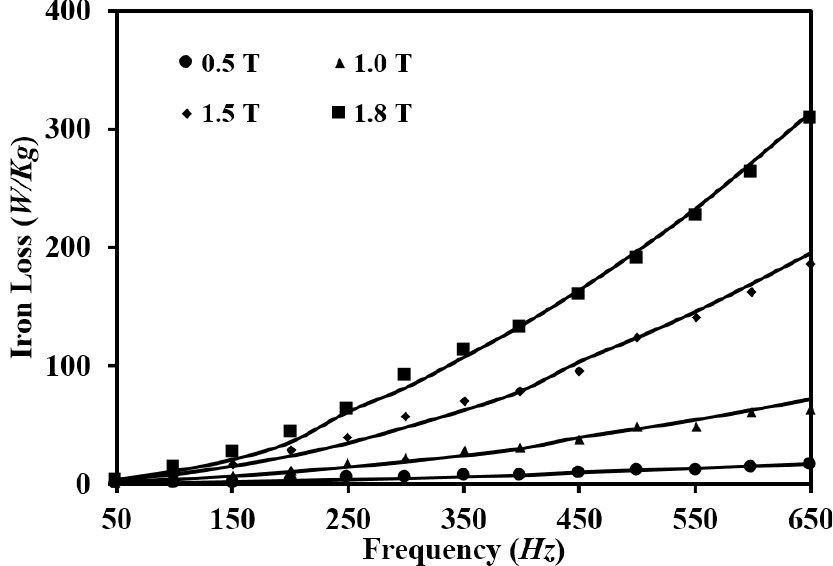
Figure 7. Iron losses with various frequencies (solid lines for the Epstein frame and data points for the ring